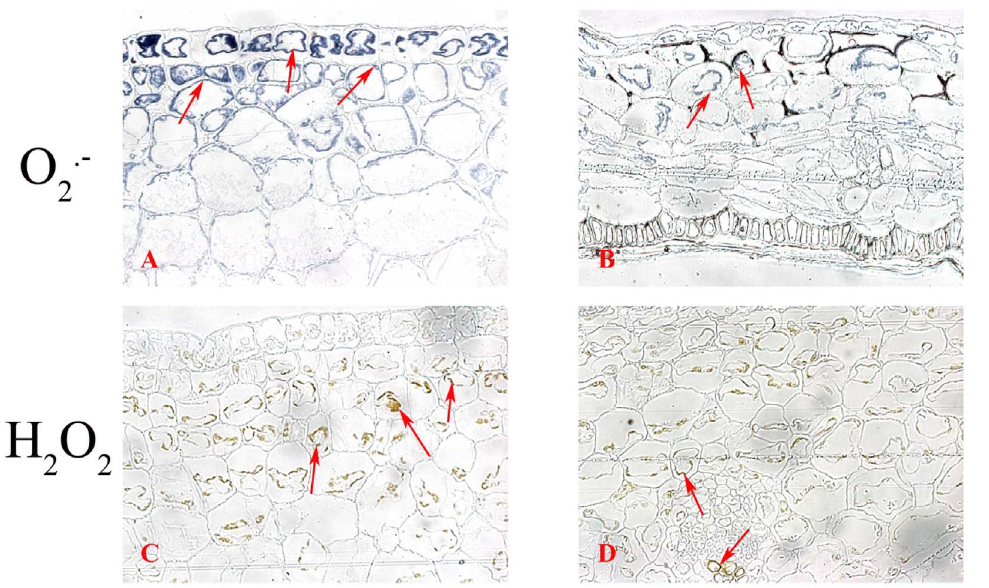
Figure 4. Cytochemical localization of reactive oxygen species in pod walls. O 2. 2 (A, B) and H 2 O 2 (C, D) in transverse sections of pod walls of P. sativum (A, B) and B. chinensis (B, D) were detected. Each panel represents microscopic observations of one transverse section of each pod from five replications. A sample was collected from both species; these samples consisted of five pods and each pod was separately collected from a different plant. O 2 . 2 and H 2 O 2 were detected by NBT and DAB staining, respectively.